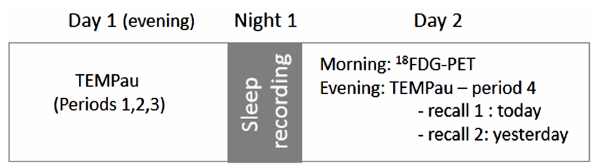
FIGURE 1 | Experimental design . Period 1: young adulthood (18–30years), period 2: last 2years (except the last month), period 3: last month, period 4: today and yesterday. Note that only AD patients benefited the PET